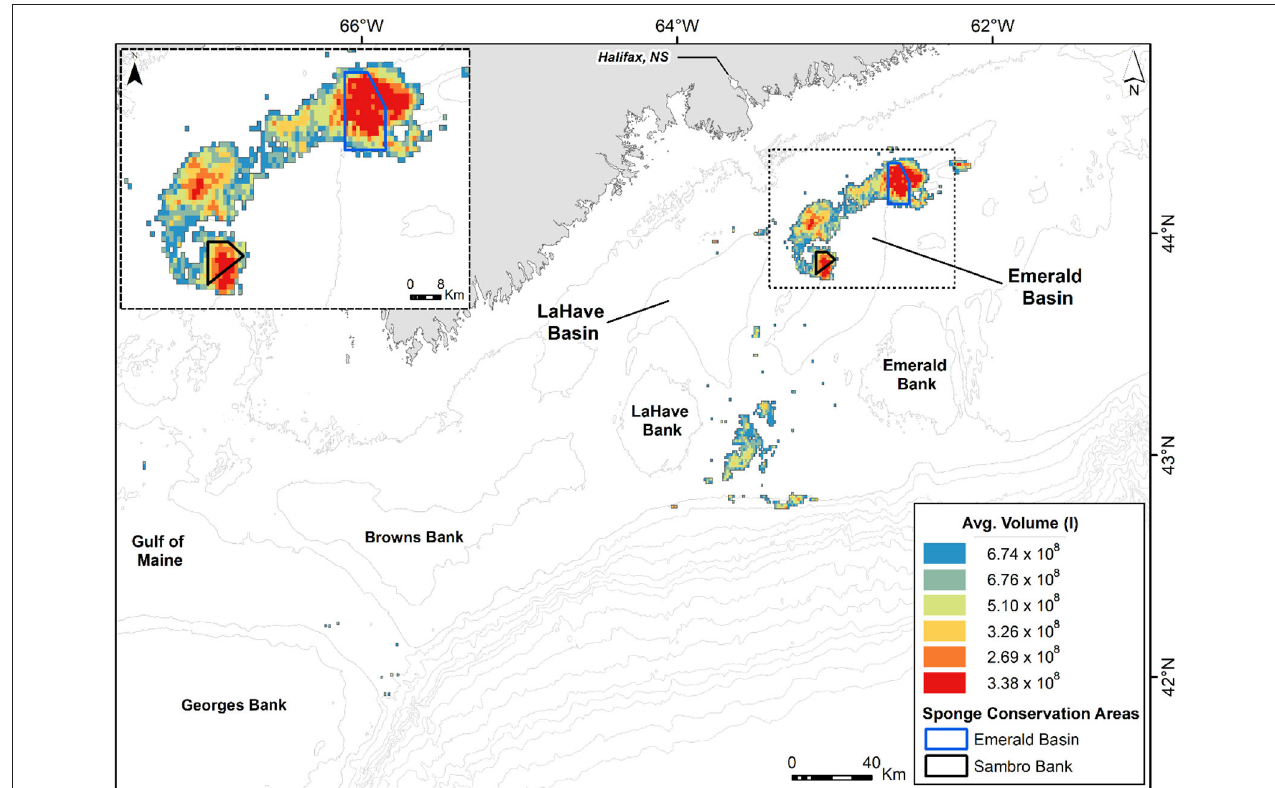
FIGURE 2 | Spatial distribution of Vazella pourtalesii biomass (by volume in liters) across the Central Scotian Shelf, as calculated in Maldonado et al. (2021). The sponge grounds correspond to areas predicted to have > 70% presence probability of the species, according to Beazley et al. (2018). The areas of densest sponge aggregation are protected from any bottom fishing activity through the creation of two Sponge Conservation Areas (SCA): Emerald Basin SCA and Sambro Bank SCA.